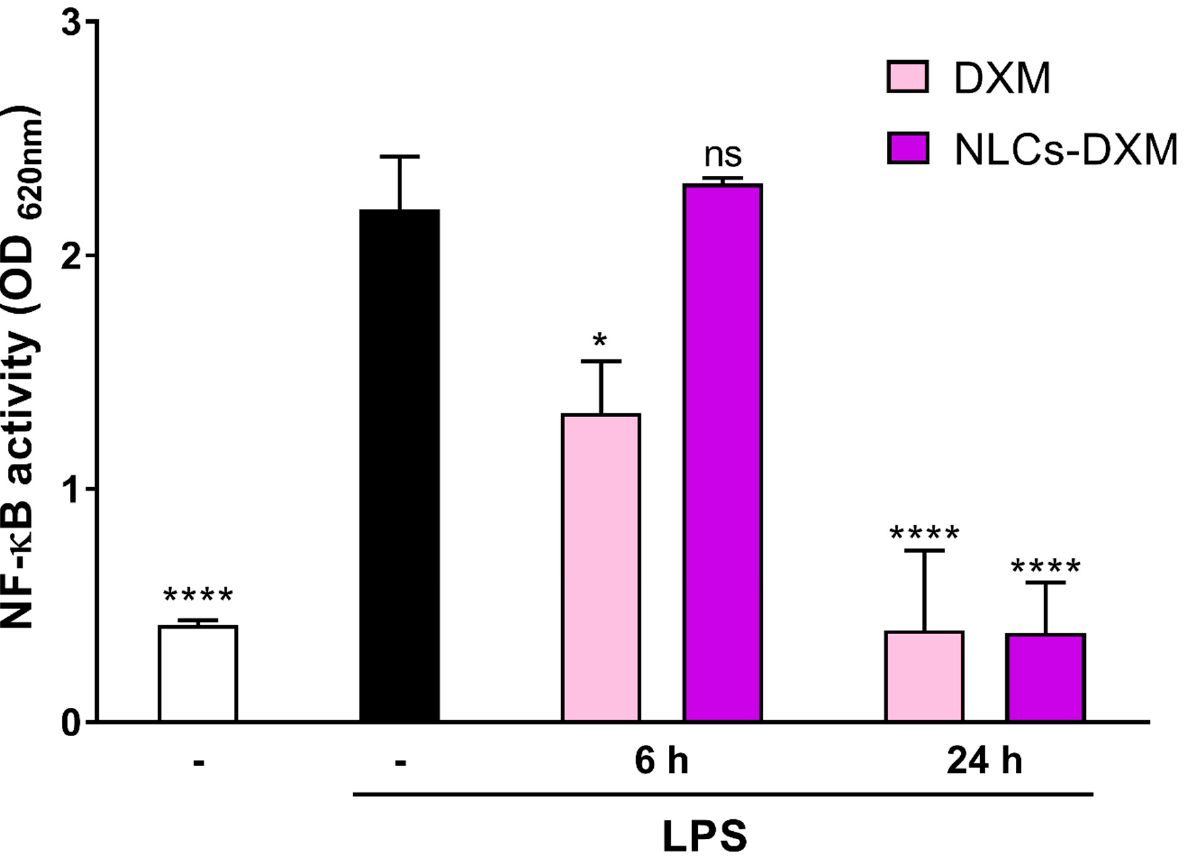
Figure 9. NLCs-DXM inhibit LPS stimulation due to delayed release of the drug. RAW-Blue™ cells, derived from RAW 264.7 macrophages and containing SEAP reporter construct inducible by NF- κβ , were pre-treated with DXM or NLCs-DXM (each 1000 µ g/mL). Next, LPS was added to the culture media to induce NF- κβ activation. DXM-mediated inhibition of this response by both treatment options was measured by NF- κβ -dependent, SEAP activation. Data represent the means ± SEM obtained in 3 independent experiments. Significant differences versus LPS + untreated cells are indicated: no significant difference (ns); * p < 0.05; **** p < 0.0001 (Two-way ANOVA, Dunnett’s multiple comparisons test).